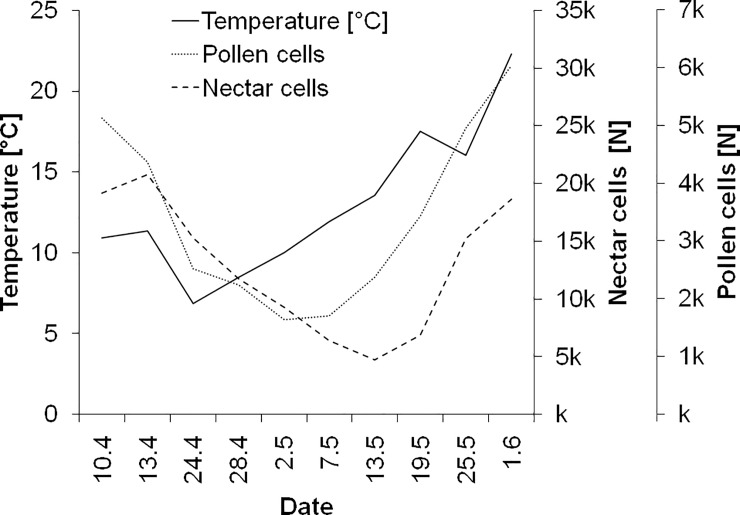
Relation of the amount of pollen cells of all control hives to temperature during the study.